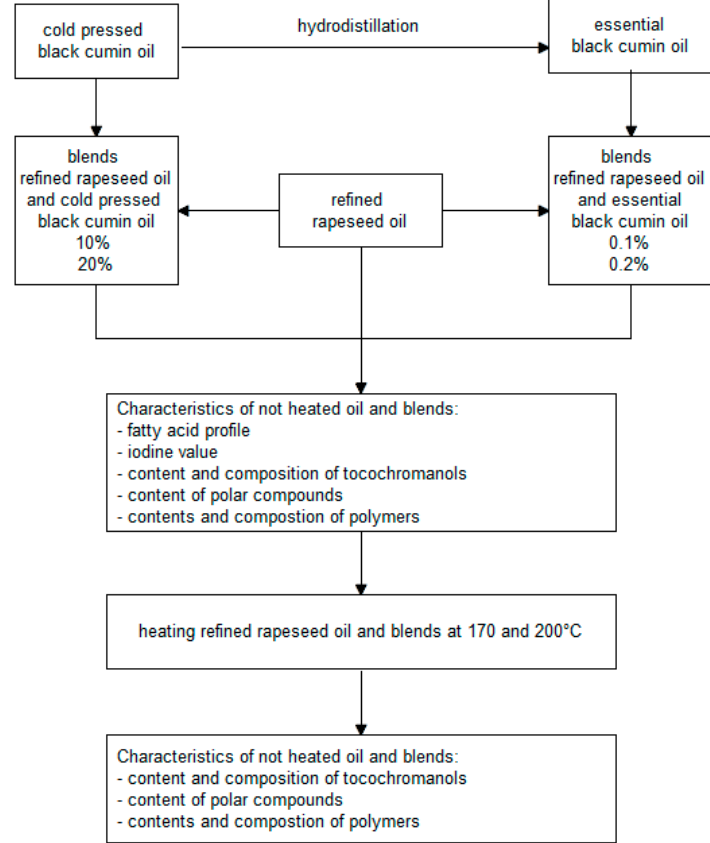
Figure 4. Graphical scheme of study approach.